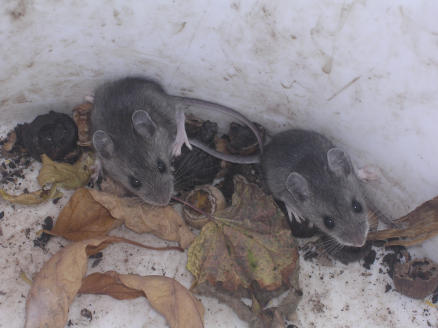
Two Juvenile White-Footed Mice (
Peromyscus leucopus) That Have Been Placed in a Plastic Pail before Being Marked with Ear Tags and Released
Mice are important reservoirs for the pathogens that cause Lyme disease, human babesiosis, human granulocytic anaplasmosis, hantavirus pulmonary syndrome, and many other diseases. They thrive in low-diversity vertebrate communities that support few predators and competitors.